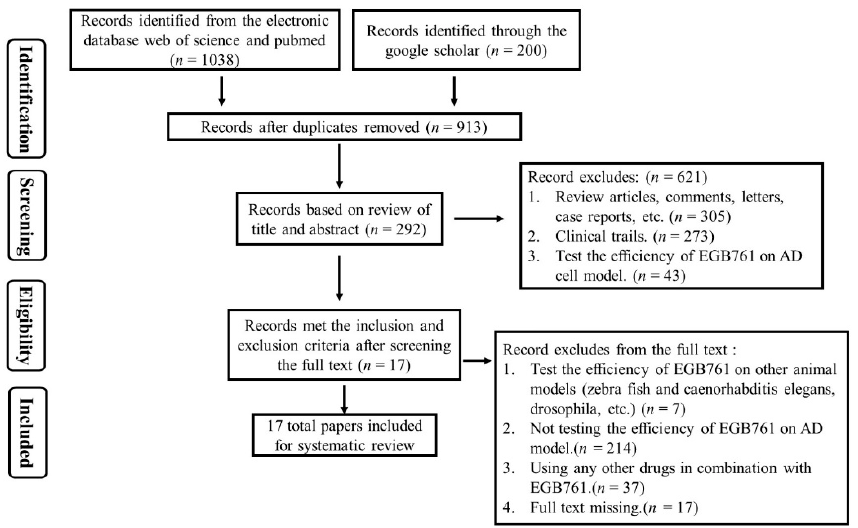
Figure 1. The screening flow chart of the preclinical studies.